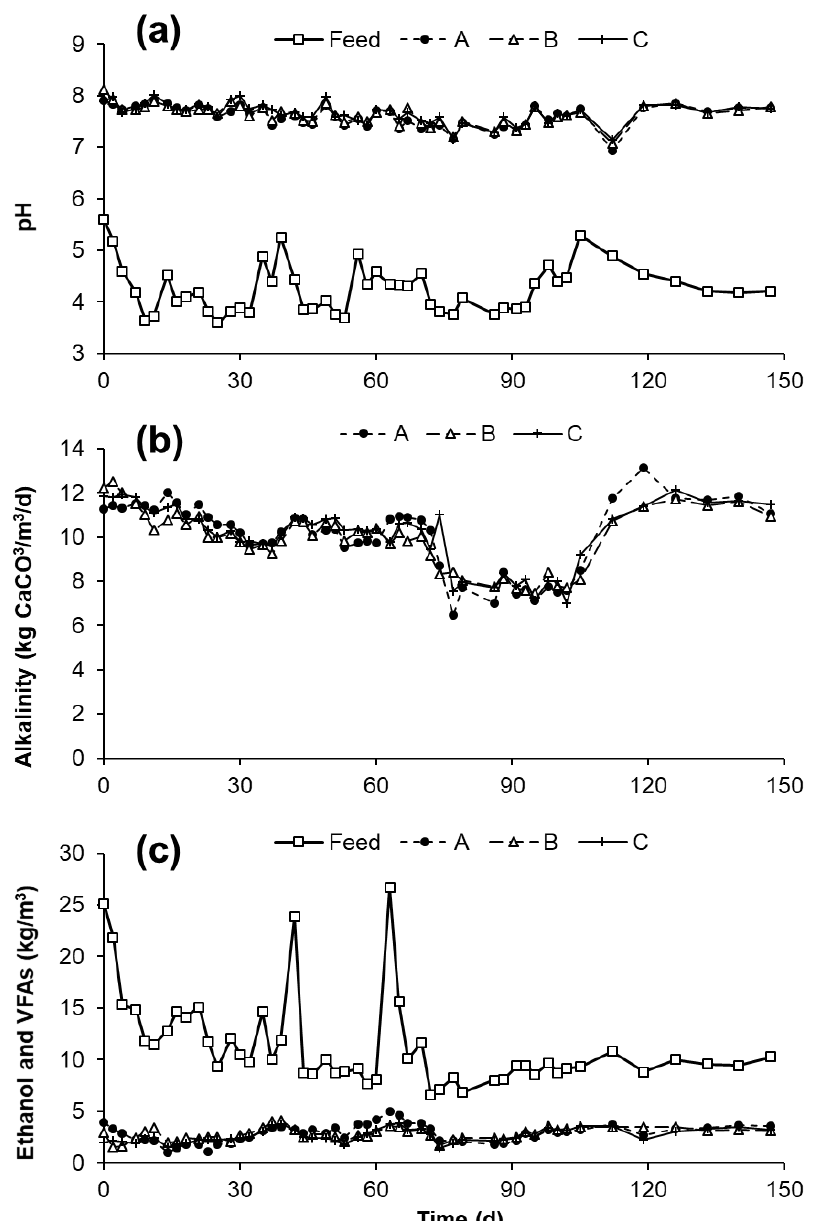
Figure 3. Profiles of selected indicator parameters for the full-scale digesters: ( a ) pH, ( b ) total alkalinity, and ( c ) ethanol and volatile fatty acids (summed). Ethanol was only detected in the influent.